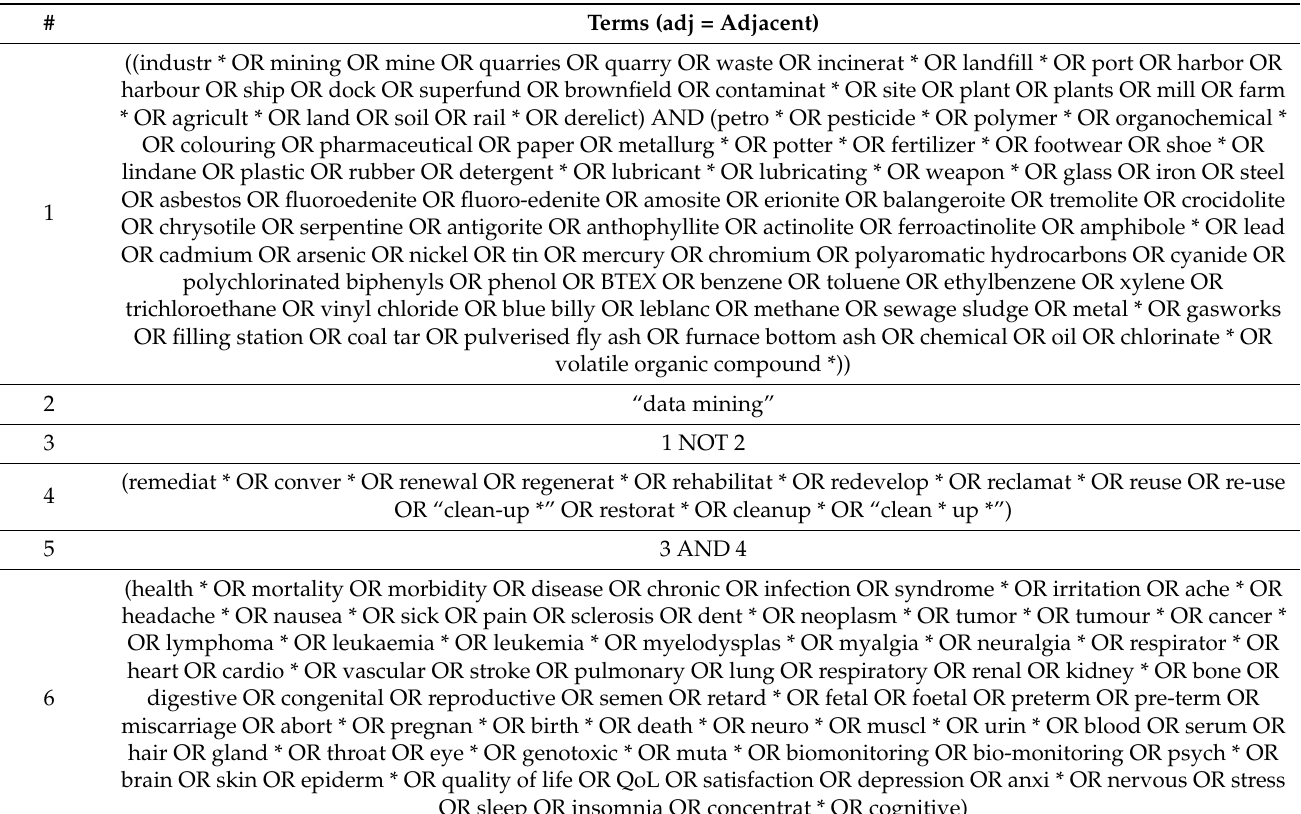
Table 1. Terms in the search